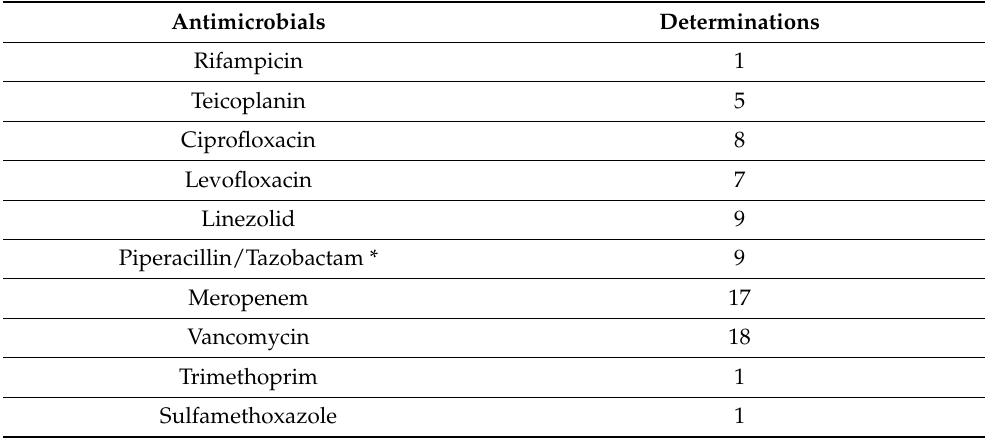
Table 2. Dosed antibiotics and number of